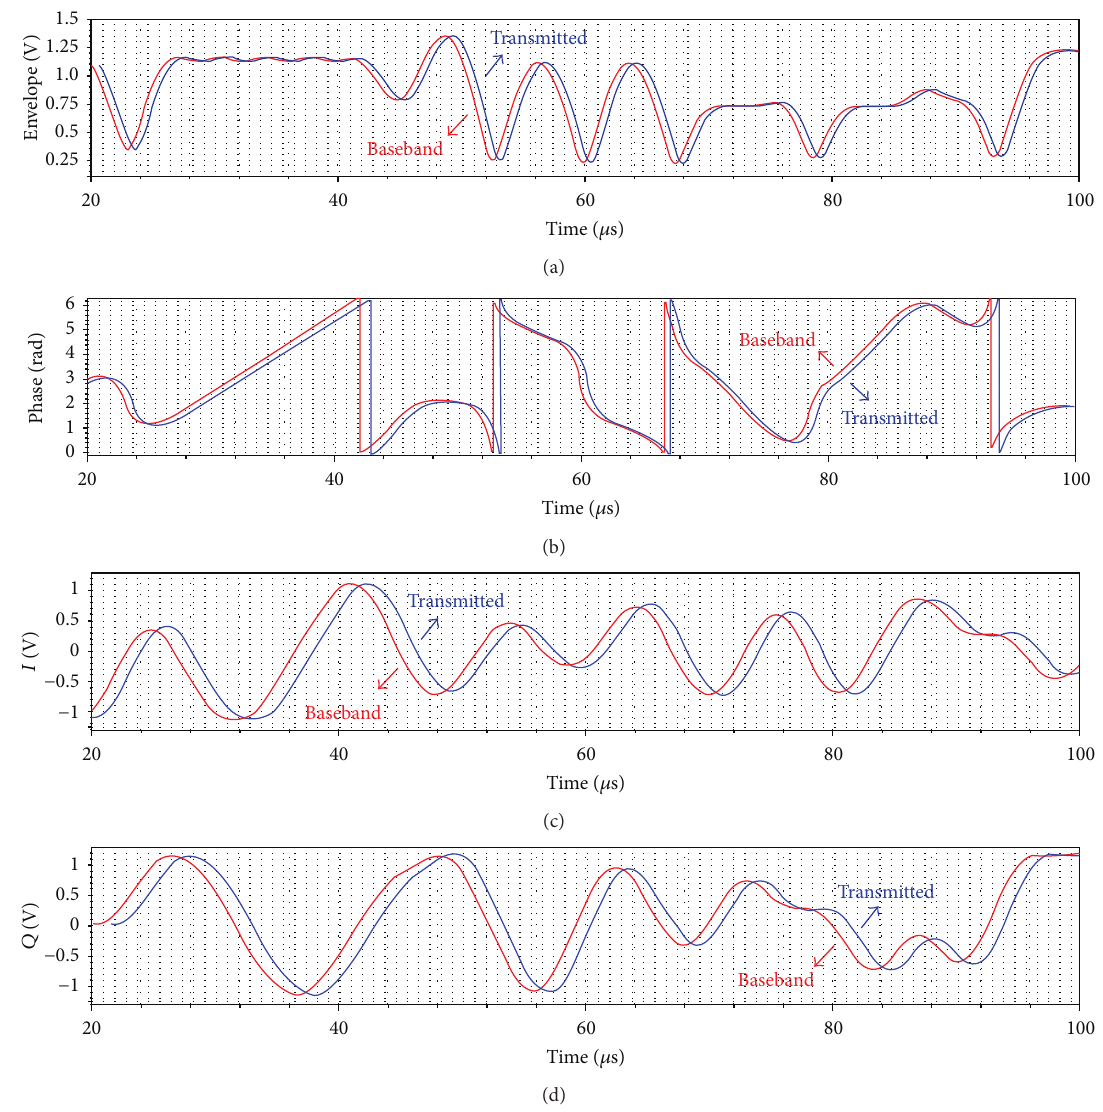
Figure 7: Simulated transmitter components conveyed by proposed architecture with comparison to baseband